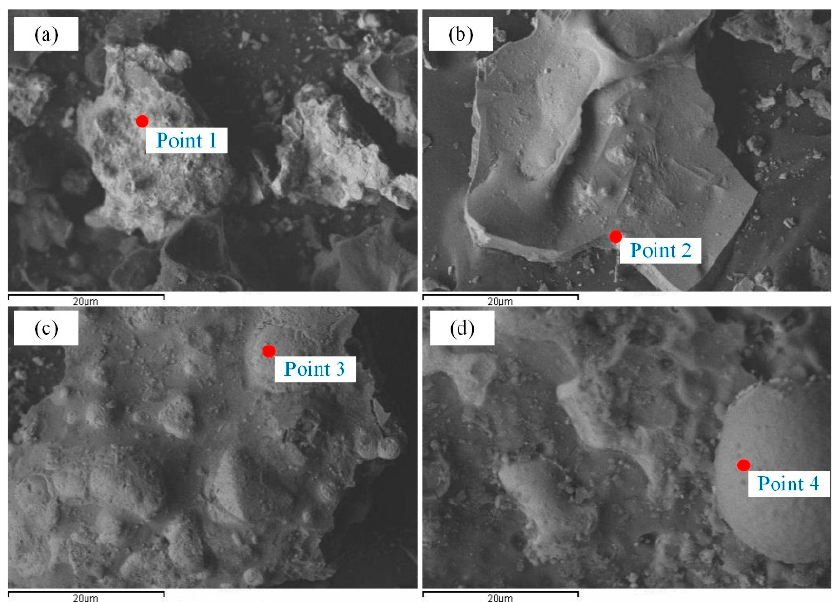
Figure 6. SEM images of coal-based reduction samples for the reduction time of 60min. ( a ) 1473 K ( b ) 1523 K ( c ) 1573 K ( d ) 1623 K.